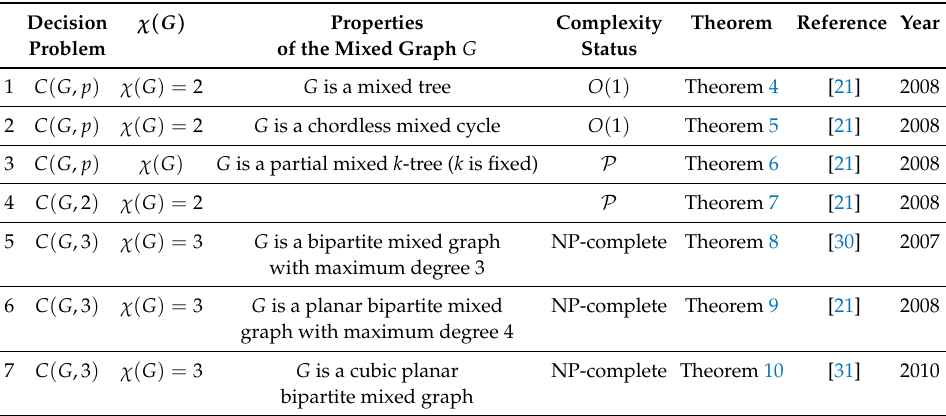
Table 1. The complexity of optimal c -colorings of the mixed graphs.